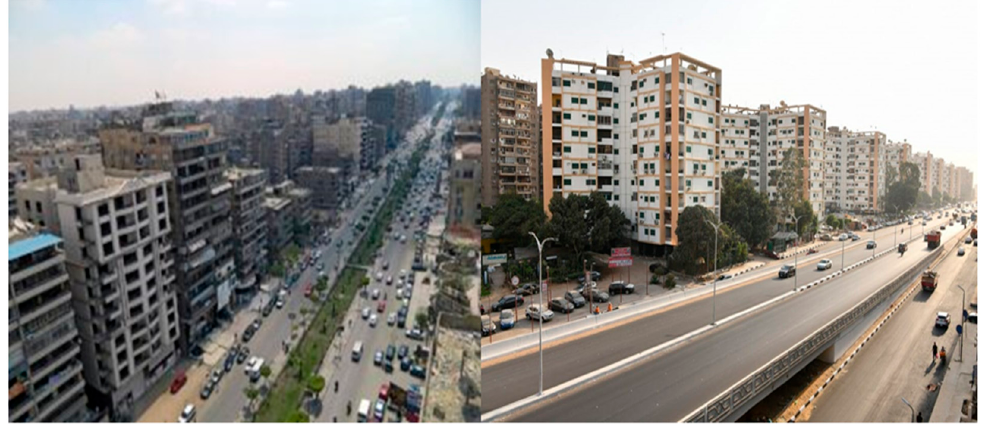
Figure 16. Typical high-rise building layouts in Cairo (Nasr City), by authors. In high-rise buildings, harvesting wind energy can be maximised by using conven- tional wind turbines on the roofs of these buildings, rather than using the energy-ball technique, but with some installation recommendations. The presence of high-rise build- ings is considered an artificial roughness element that modifies the regular airflow pattern associated with ground effects. To install wind turbines in such situations, a rotor height of not less than 6 m above roof level is required. Considering the wake effect, small-power wind turbines must be installed staggered. A typical building footprint is 20 m × 30